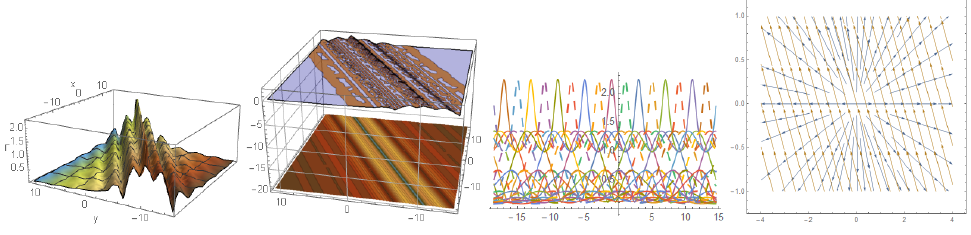
Figure 9. The sketch of Γ 4 ( x , y , t ) in Equation (31) via q 3 = 6, c = 1, e 4 = 4, ρ = 2, q 5 = 3, η = 1, q 2 = 5, λ = 1, q 7 = 11, m 0 = 5, and t = 3.